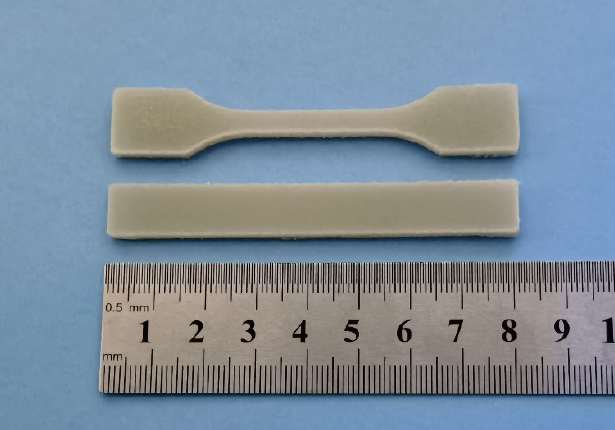
Figure 13. An example of printed specimens (S-3) for tensile and notched Izod tests.